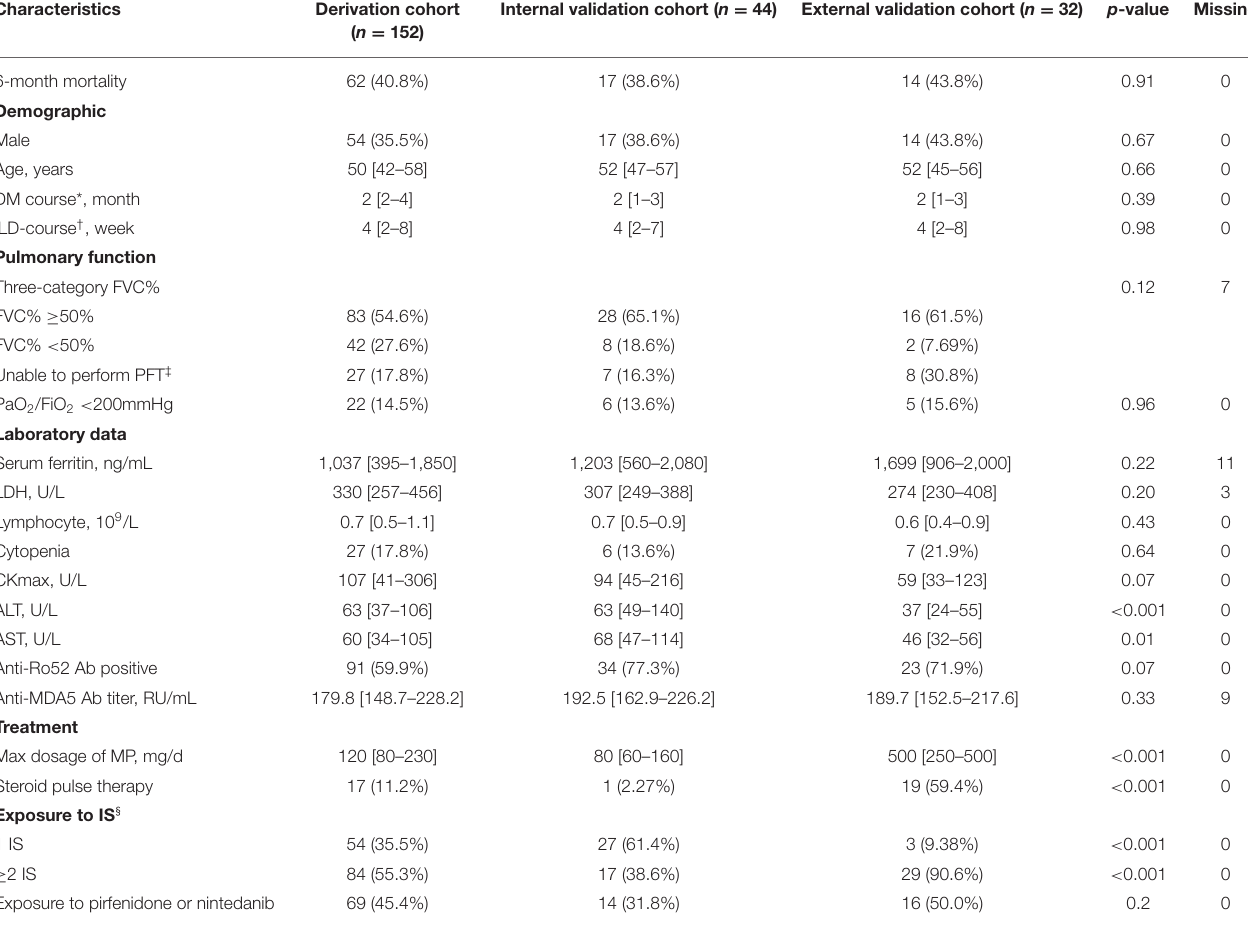
TABLE 1 | Comparison of baseline clinical features and outcomes between three cohorts.